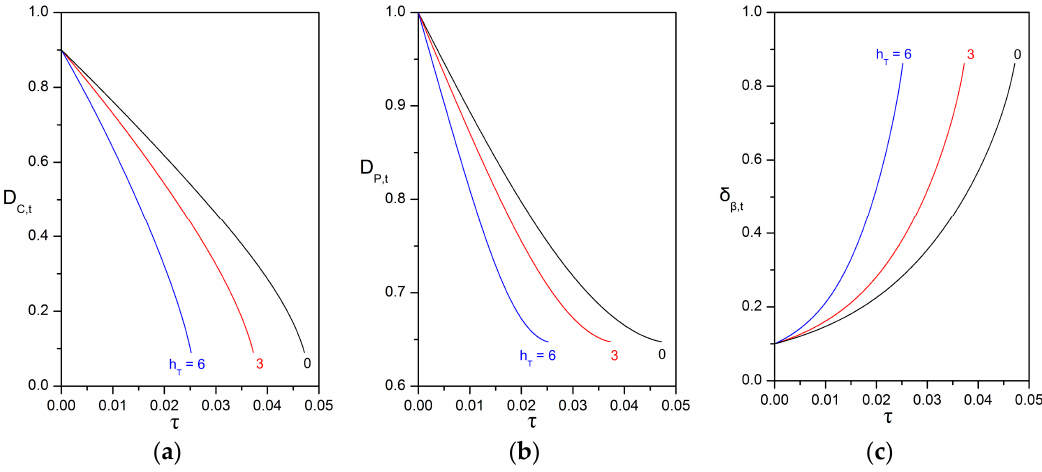
Figure 5. Impact of the initial Thiele modulus on the evolution of: ( a ) the dimless diameter of the oily core; ( b ) the dimless diameter of the compound particle; ( c ) the dimless thickness of the biofilm shell. The values of the other parameters are: δ β ,0 = 0.1; Pe υ ,0 = 100; Da υ = 0; Λ A β = 1; H A , υ / β = 1; Y β / A = 0; k srn = 0; velocity mode = “const.